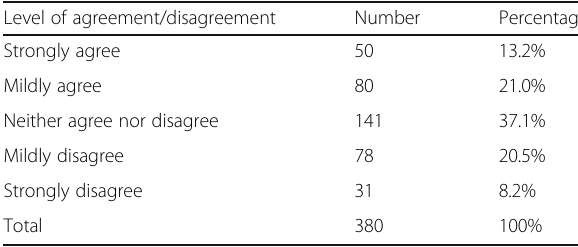
Table 6 Meat consumption does not impact on human wellbeing and the ecological health of the planet: 2018 Sydney